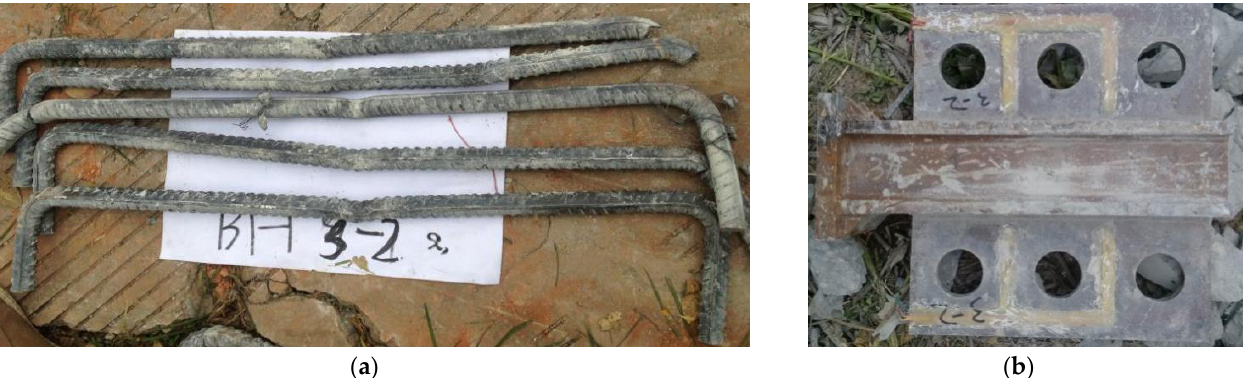
Figure 8. Rib plate and reinforcement of the BH 3-2 specimen after the test: ( a ) Deformation form of reinforcement; ( b ) Deformation form of rib plate.